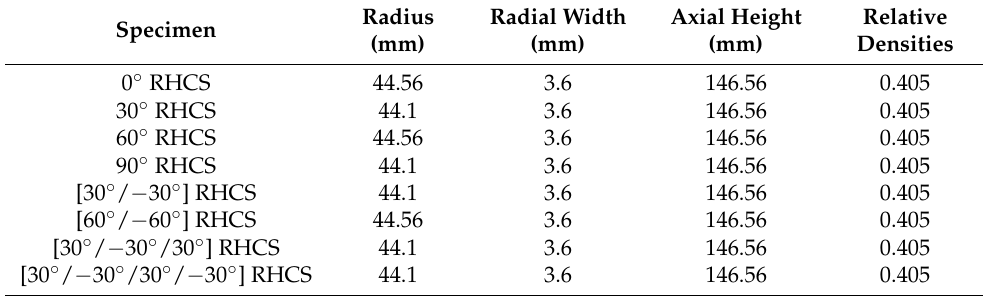
Figure 7. The nominal stress-strain curves of the PLA material. Quasi-static compression tests were performed to investigate the mechanical proper- ties of cylindrical structures using a testing machine. The quasi-static uniaxial compres- sion tests were conducted with a loading speed of 1 mm/min. Finite element software ABAQUS/Explicit (2020) was used to simulate the quasi- static compression process of honeycomb cylindrical shells. The experimental data for the PLA material were fitted in ABAQUS. The boundary condition is shown in Figure 8. The bottom plate was fixed and the top plate was given a vertical constant velocity of 1 m/s. The cylindrical shells were contacted with plates and a surface-to-surface contact was em- ployed with a fraction coefficient of 0.3. General contact was adopted to simulate the com- plex mutual contact during compression. The friction coefficient of the tangential behavior was 0.15, and the Hard contact was selected for the normal behavior. A 10-node modified quadratic tetrahedron, namely the C3D10M element, was used to mesh the cylindrical shells. A mesh sensitivity analysis was carried out to guarantee that the simulation results